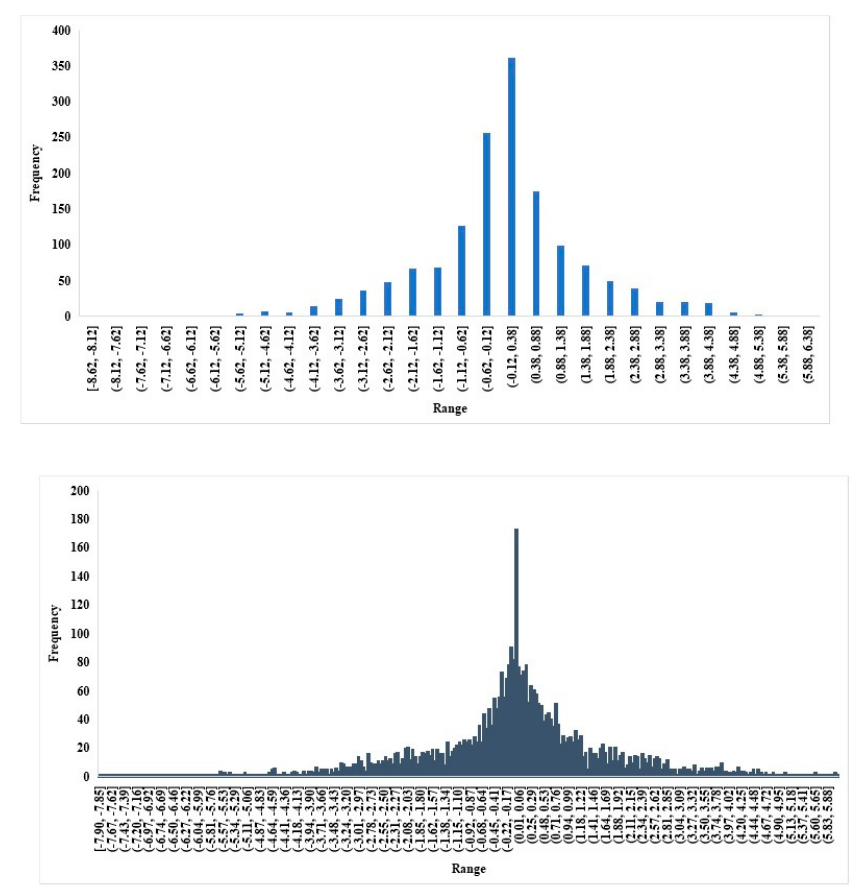
( below ) testing Figure 26. The MPF (five inputs) error histograms: ( above ) training phase, and ( below ) testing phase.